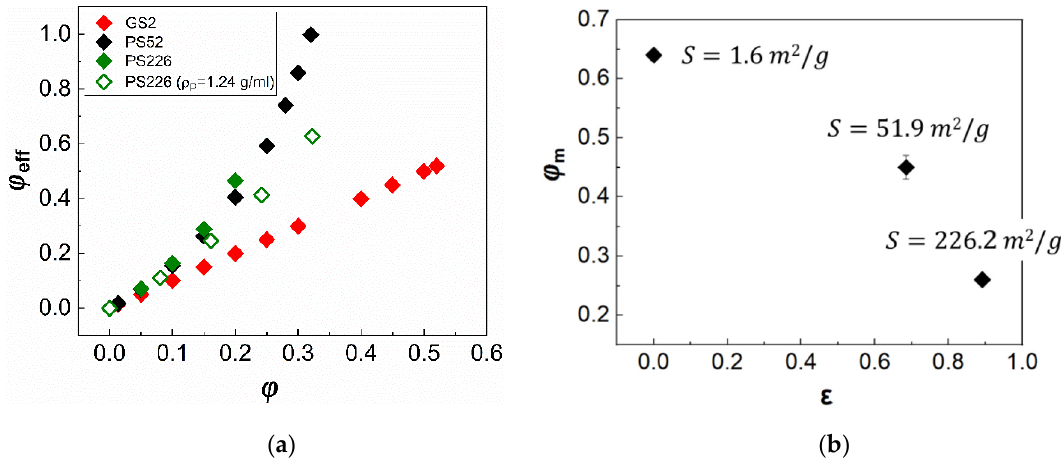
Figure 5. ( a ) E ff ective volume fraction ( ϕ ef f ) plotted as a function of apparent particle volume fraction ( ϕ ) and ( b ) maximum packing fraction of all suspensions as a function of porosity ( ε ); the specific surface area ( S ) values are also shown in the figure. The ϕ ef f of the PS226 particles was estimated using both the material density ( ρ p = 2 g/mL) (green filled diamonds) and the experimentally measured density ( ρ p = 1.24 g/mL) (green open diamonds).